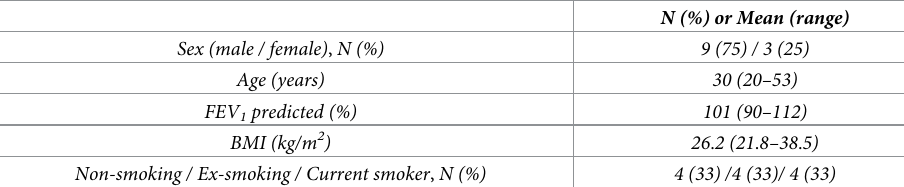
Table 2. Participant characteristics.